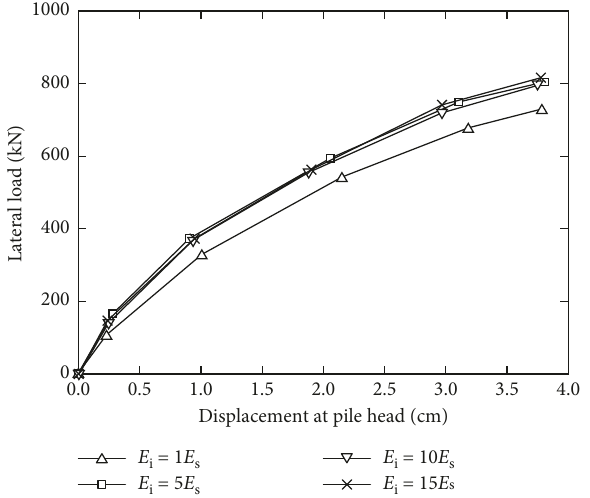
Figure 4: Effect of stiffness of the interface element on the lateral load-displacement